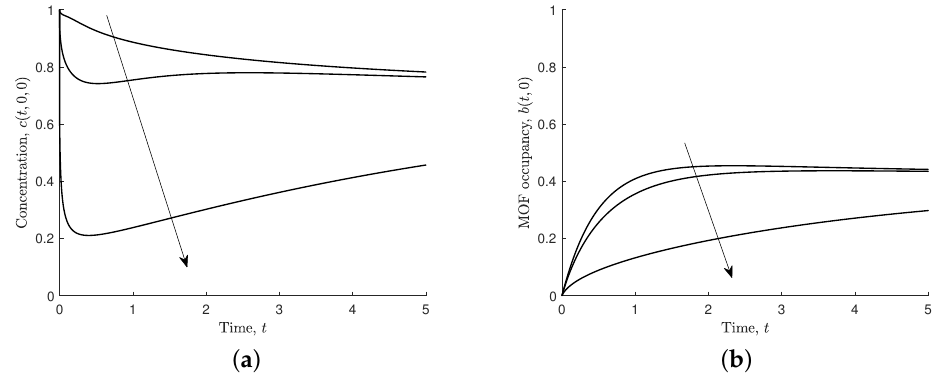
Figure A3. Results for different values of effective capacity, s 4 = 0.1,1,10, s 1 = s 2 = s 3 = 1, and D = 0.5. Arrows indicate the direction of increasing s 4 . ( a ) Non-dimensional concentration of ferric ions through MOF-mid point across two media, c ( t ,0, x 2 ) . ( b ) Non-dimensional MOF occupancy, b ( t ,0 )